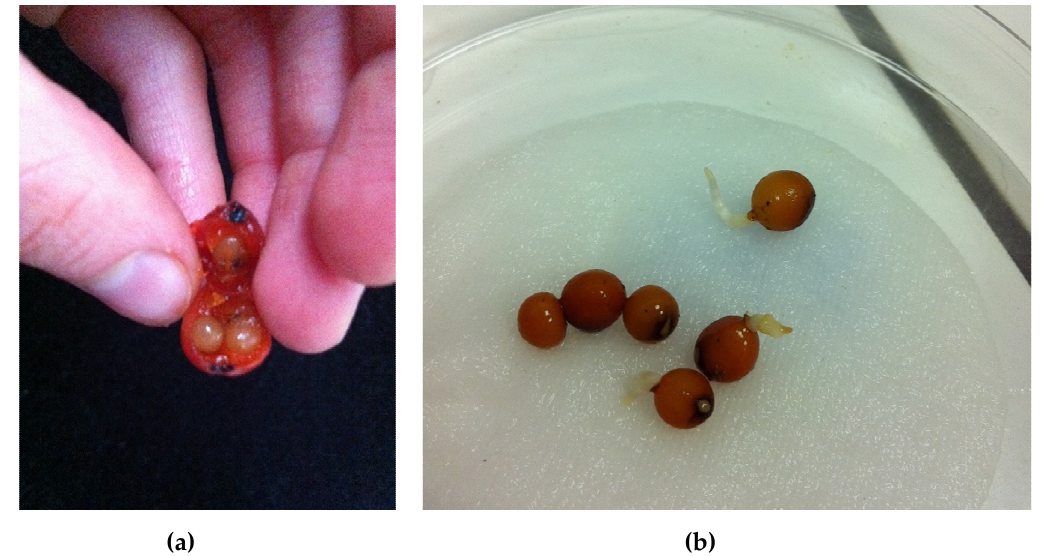
Figure 2. Example of three-seed fruit ( a ), and germinating seeds on cotton swabs ( b ).